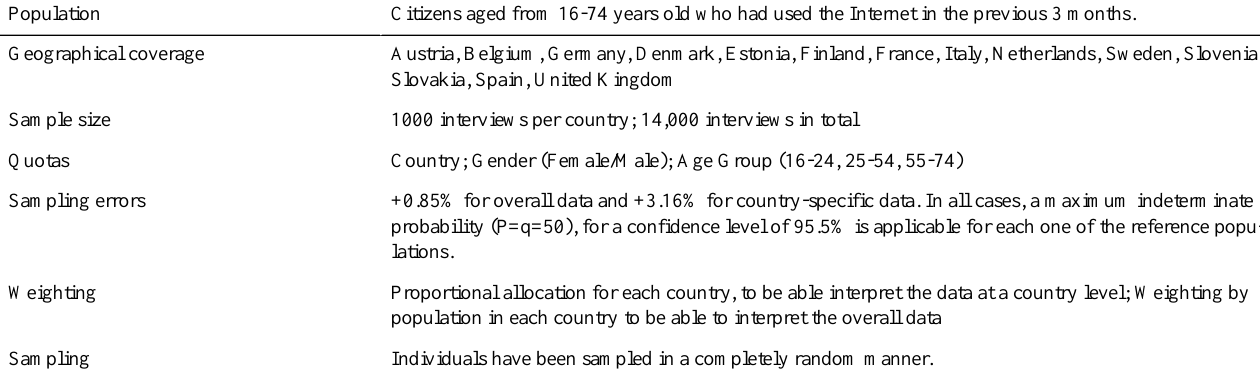
Table 1. Sampling